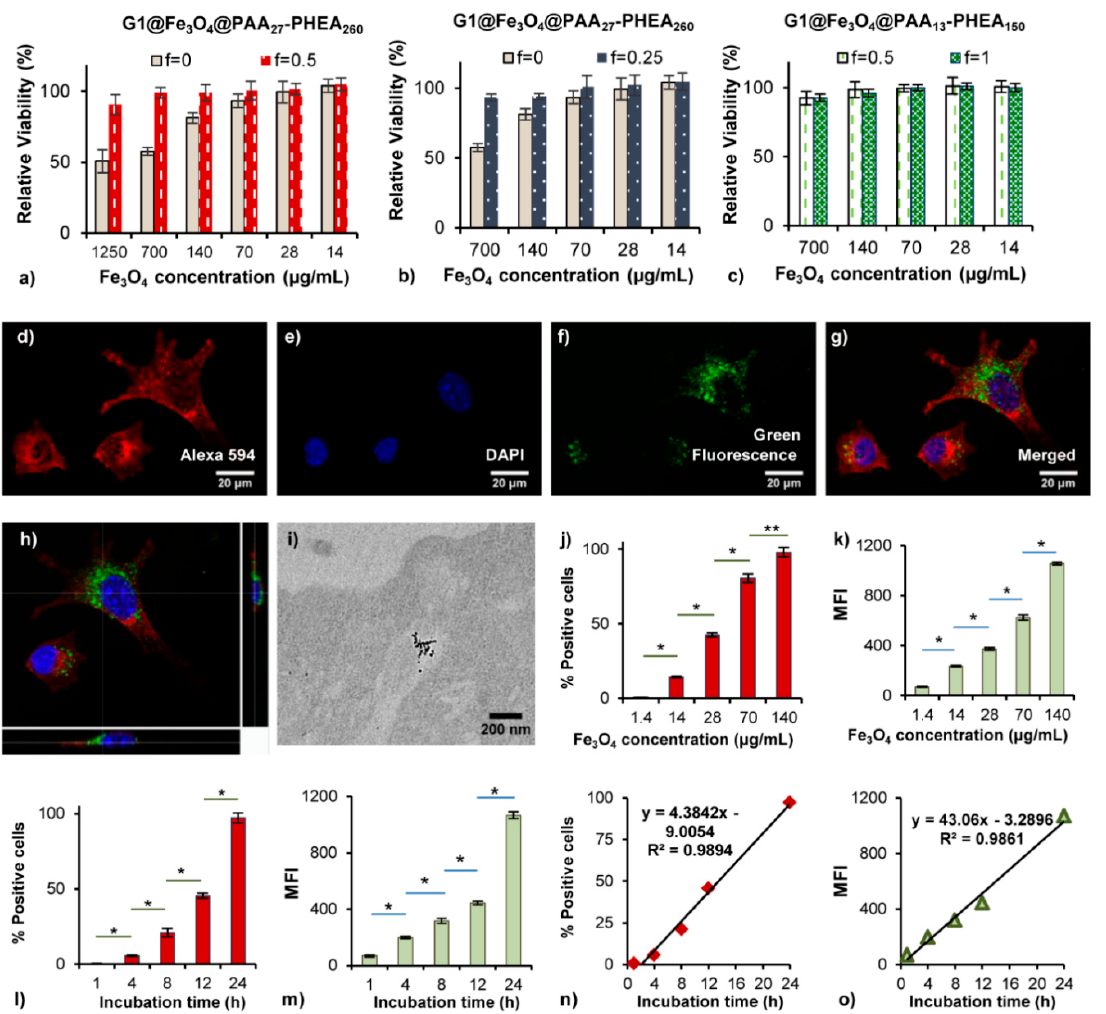
Figure 4. ( a – c ) Cytotoxicity profiles for uncoated MNPs G1@Fe 3 O 4 ( f = 0) and MPIC